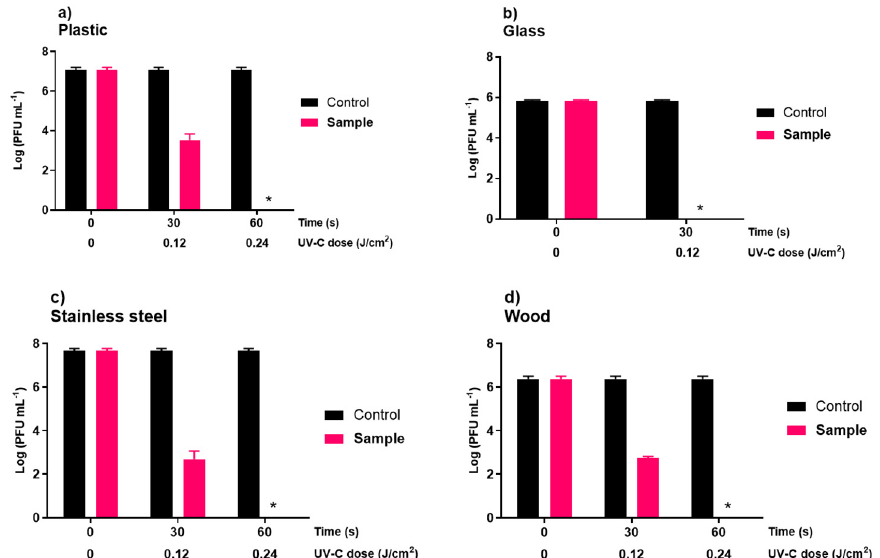
Figure 3. Inactivation of phage φ 6 by the UV-C sterilizing chamber (8)5.5W on inanimate surfaces: plastic ( a ), glass ( b ), stainless steel ( c ), and wood ( d ). Limit of detection was about 2.3 log PFU/mL Values represent the mean of the three experiments and error bars represent the standard deviation. * below the methods’ detection